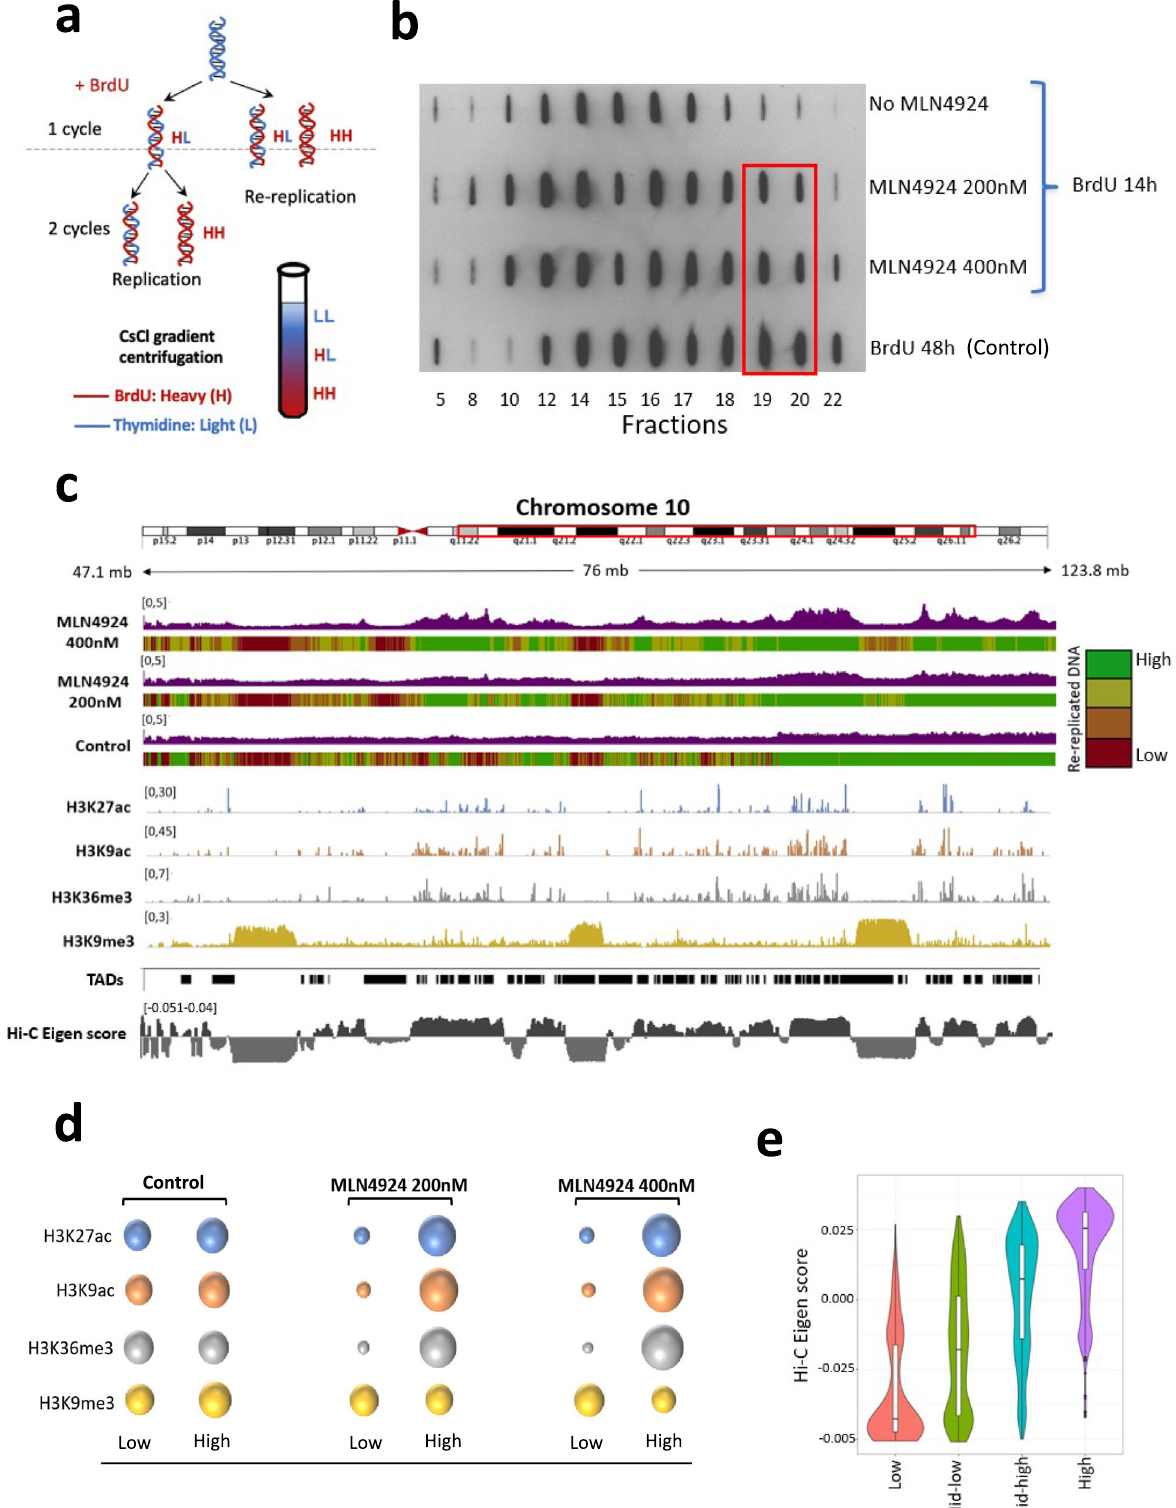
replicating genome. Consistent with our combing results, we did not detect sharp, high peaks, suggesting that MLN4924 treated cells did not re-initiate multiple rounds of DNA synthesis immediately following the initial round of replication. We next asked whether regions that were over-represented in re-replicated DNA shared common epigenetic properties.